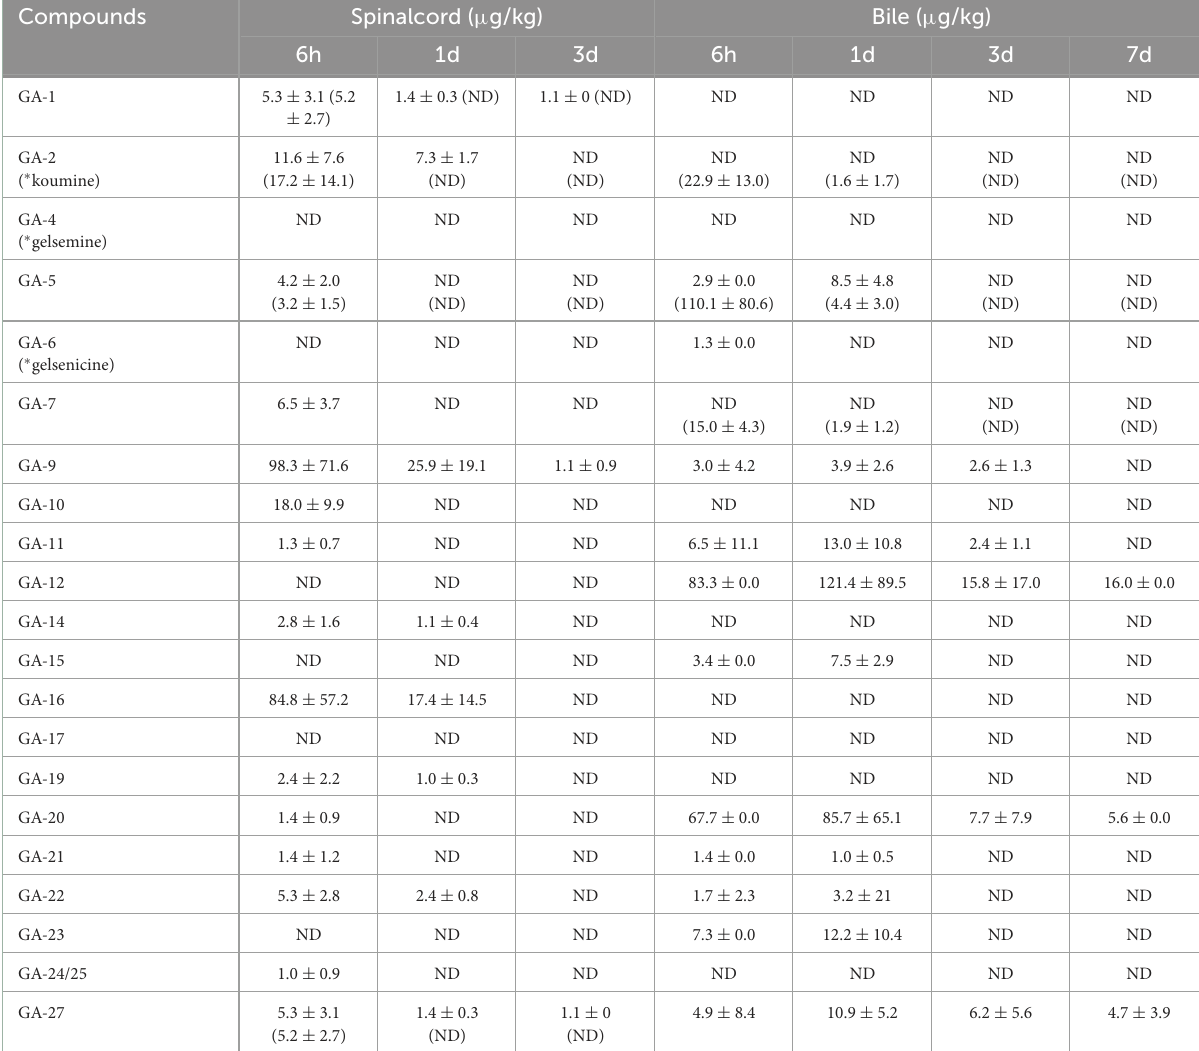
TABLE 5 Concentrations of Gelsemium alkaloids in pig spinal cord and bile after 45 d of consecutive administered G. elegans powder at a dose of 2% per kilogram feed ( µ g/kg) ( n = 5).